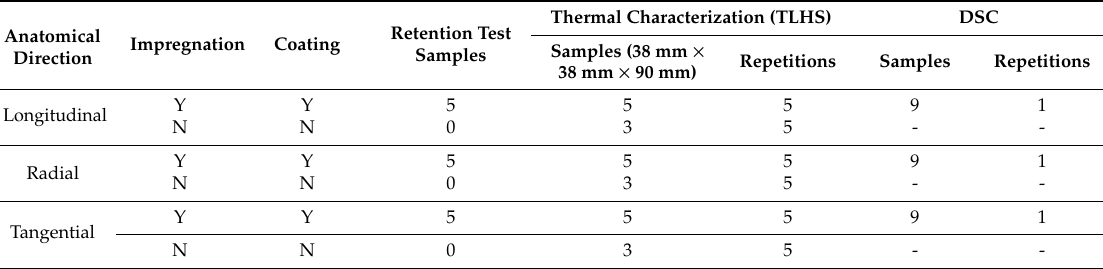
Figure 6. Temperature control for the DSC analysis. Table 3. Summary of the experimental procedures with wood samples (TLHS: transient line heat source method).